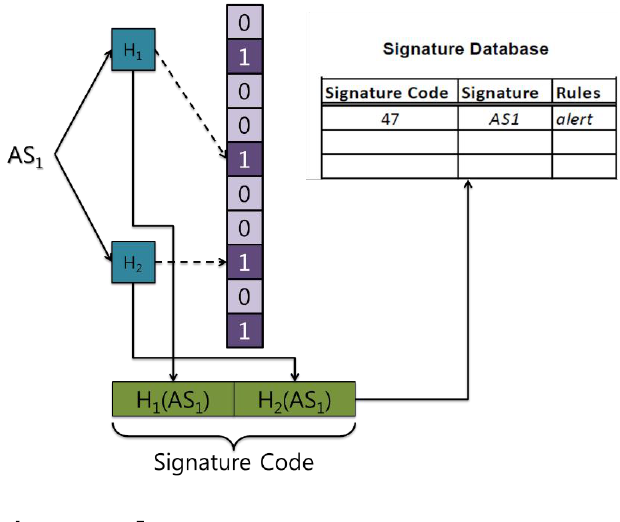
Figure 2. IDS operation using Bloom